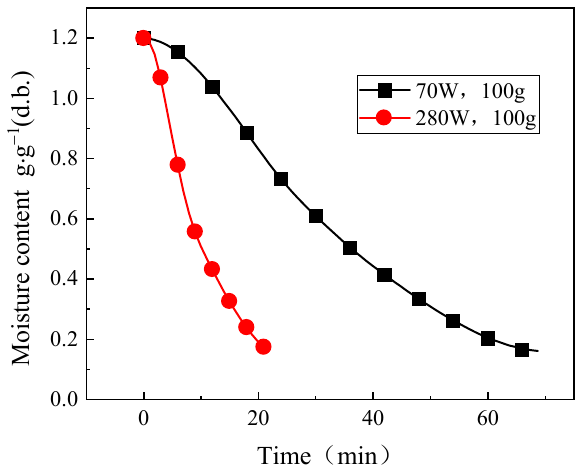
Figure 2. Moisture content of corn under different microwave powers.